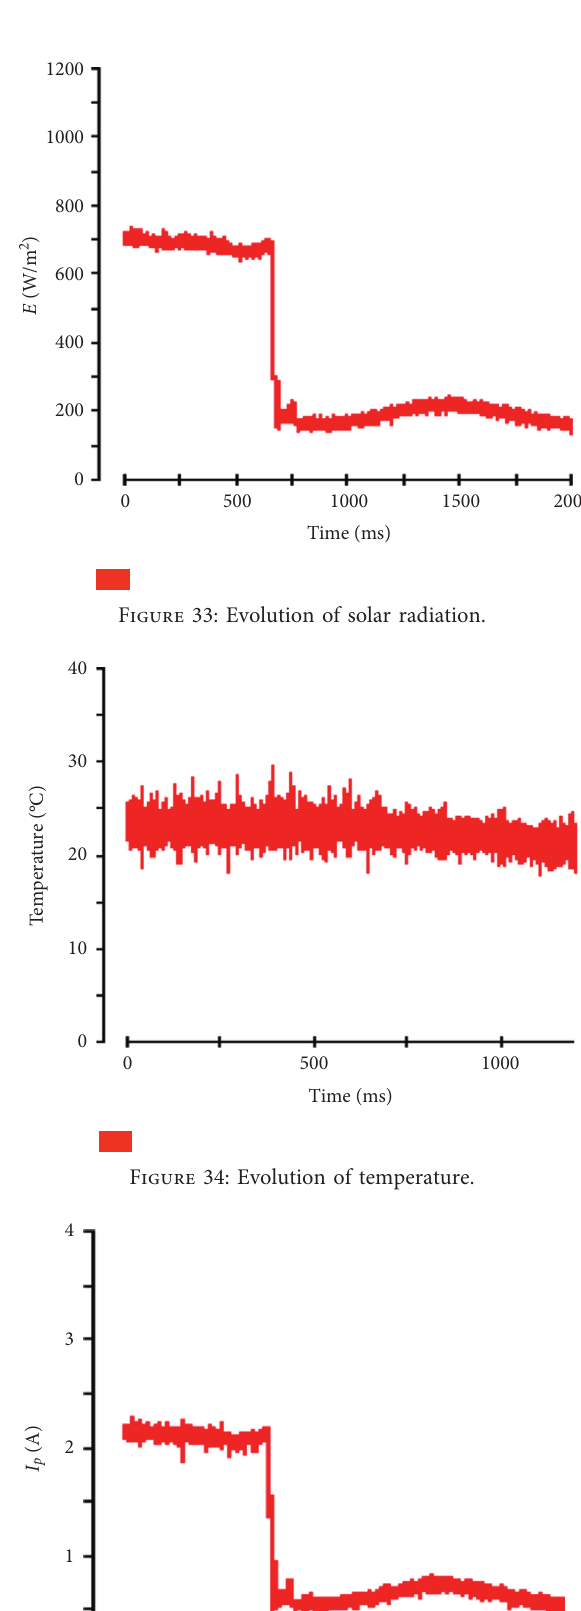
Figure 35: Evolution of real current of